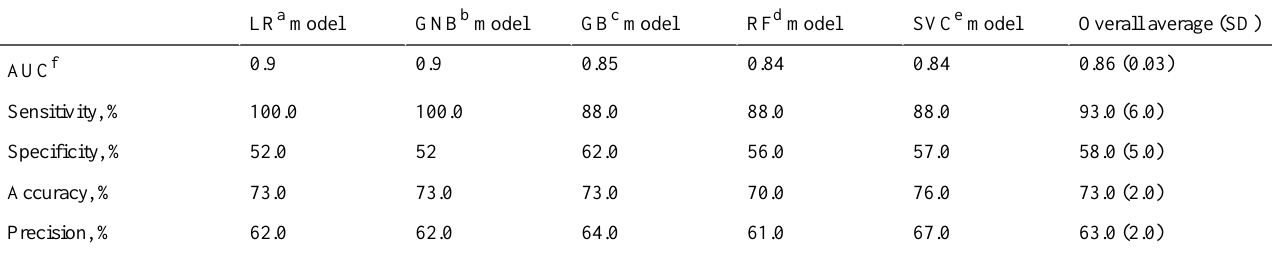
Table 2. Results of the test set metrics for the final